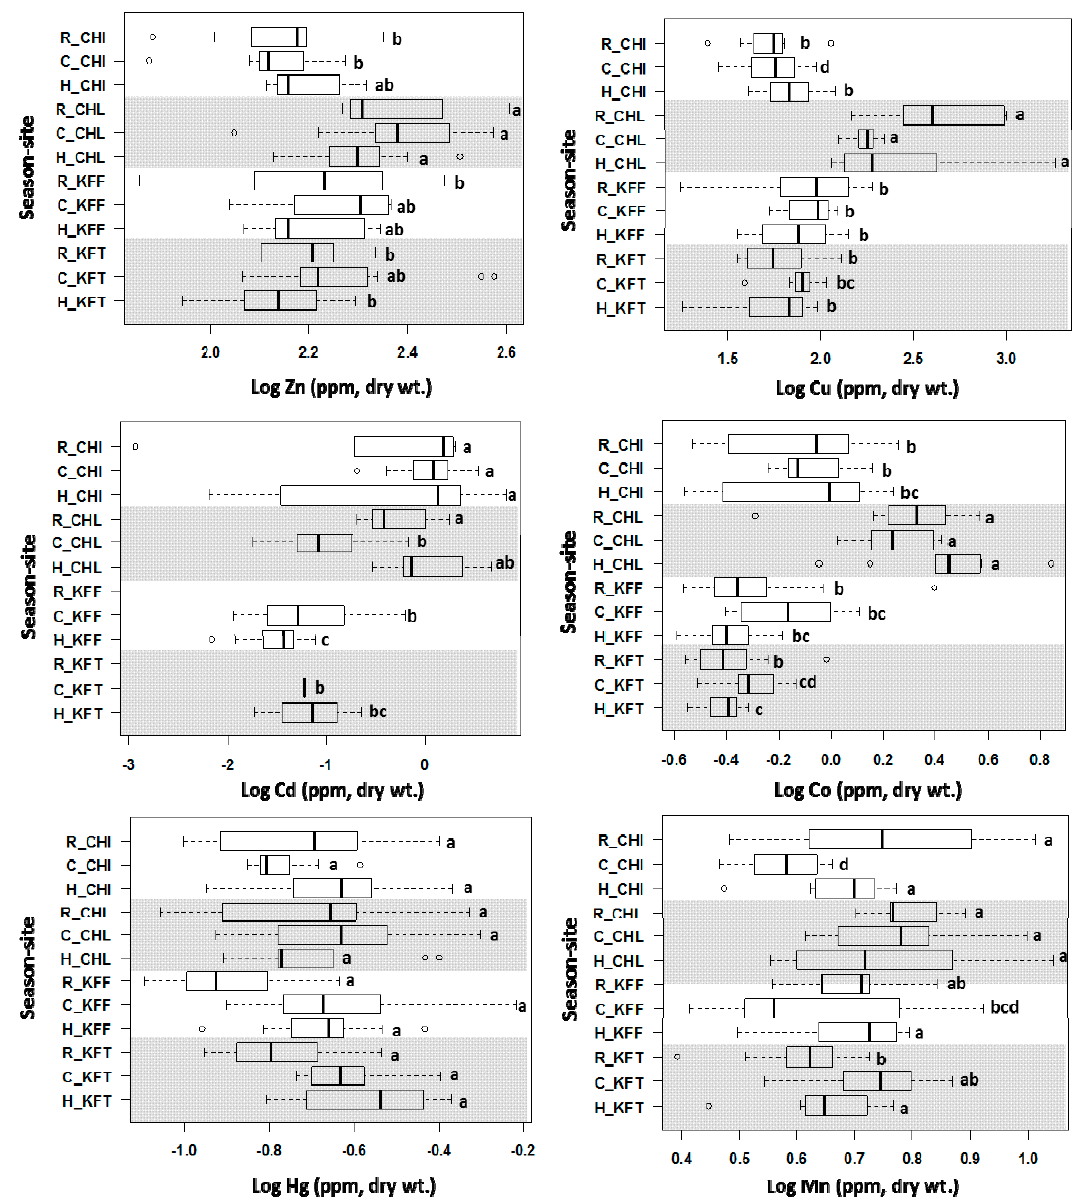
Figure 6. Levels of selected metals in liver tissue of C. gariepinus collected from four sample sites (CHI = Chimfunshi, CHL = Chililabombwe, KFF = Kafue Flats, KFT = Kafue Town) during three distinct seasons (R = warm-rainy season, C = dry-cold season, H = dry-hot season); sites are distinguished by different shading. One-way ANOVA followed by a post-hoc Tukey’s (HSD) test was applied to assess for spatial and seasonal differences in heavy metal levels. In the plots shown, levels for individual metals not connected by the same letter (“a”, “b” or “c”) are significantly different ( p < 0.05) between sites, as analysed for each individual season. The ○ symbols in these box-and-whiskers plots denote outliers. Note that the logarithmic x axes scales are different for individual metals. In cases where no data are given, the respective metal was below detection limits. Also see Table S3 and Figure S4.